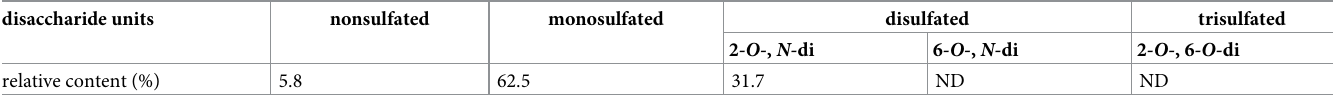
Table 1. GAG composition of cochlear tissue from 8-week-old female C57BL/6 mice. disaccharide